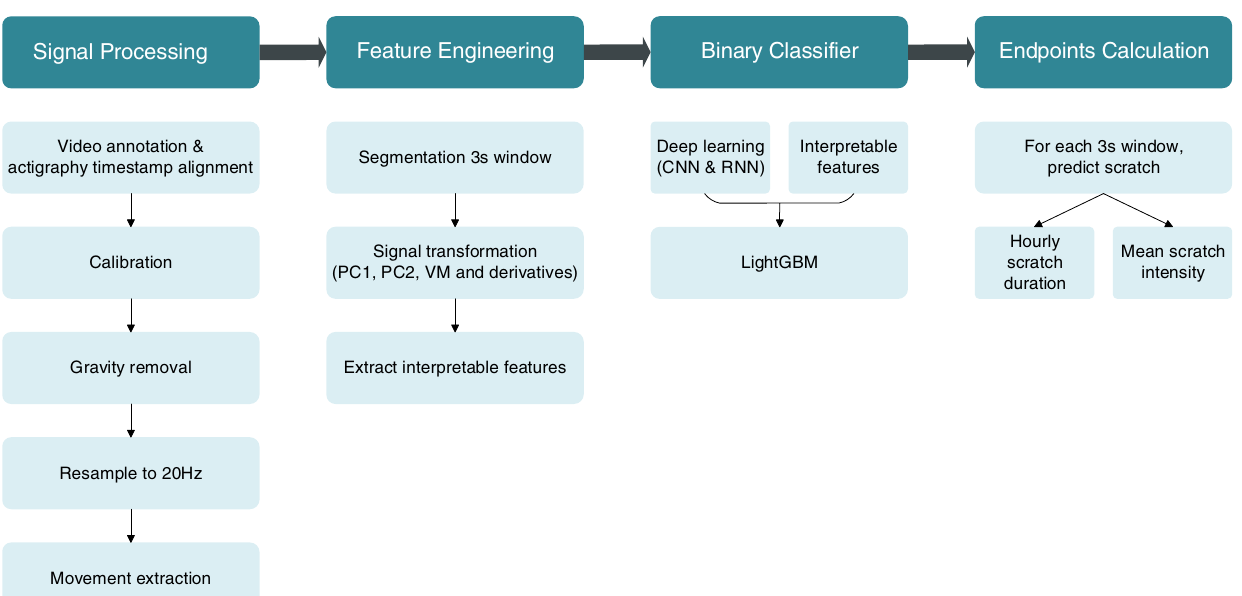
Fig. 5 Overview of proceess from signal processing to endpoints calculation. Overview of signal processing, feature engineering, modeling, and digital endpoints calculation.